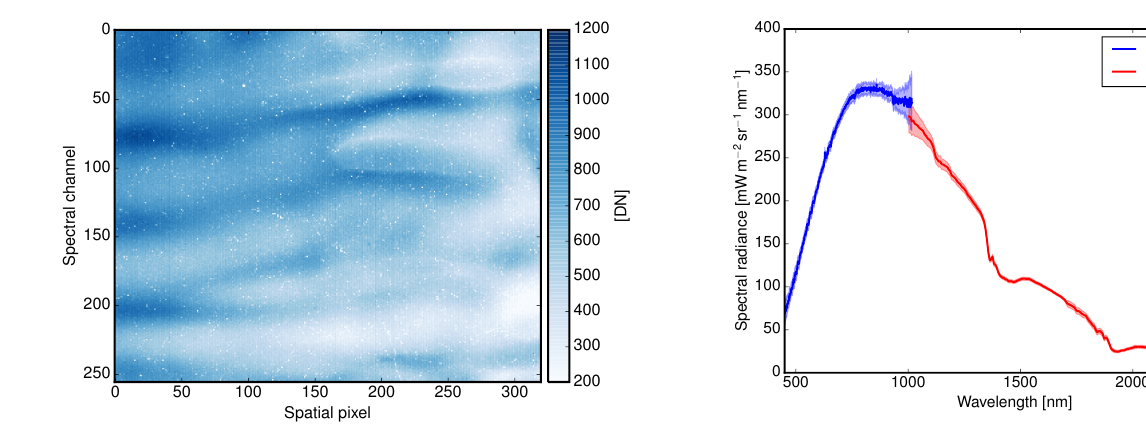
Figure 10. Reconstructed spectral radiance on top the large inte- grating sphere during the respective radiometric